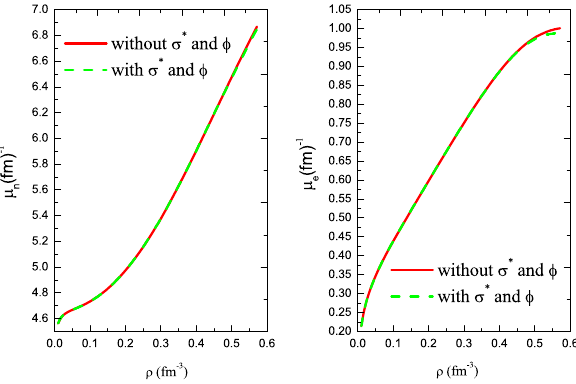
Fig. 4 The chemical potentials of neutrons and electrons as a function of baryon density ρ . The thick solid red curves represent the case where the hyperon interaction is not considered, while the green virtual curves represent the case where the hyperon interaction is considered